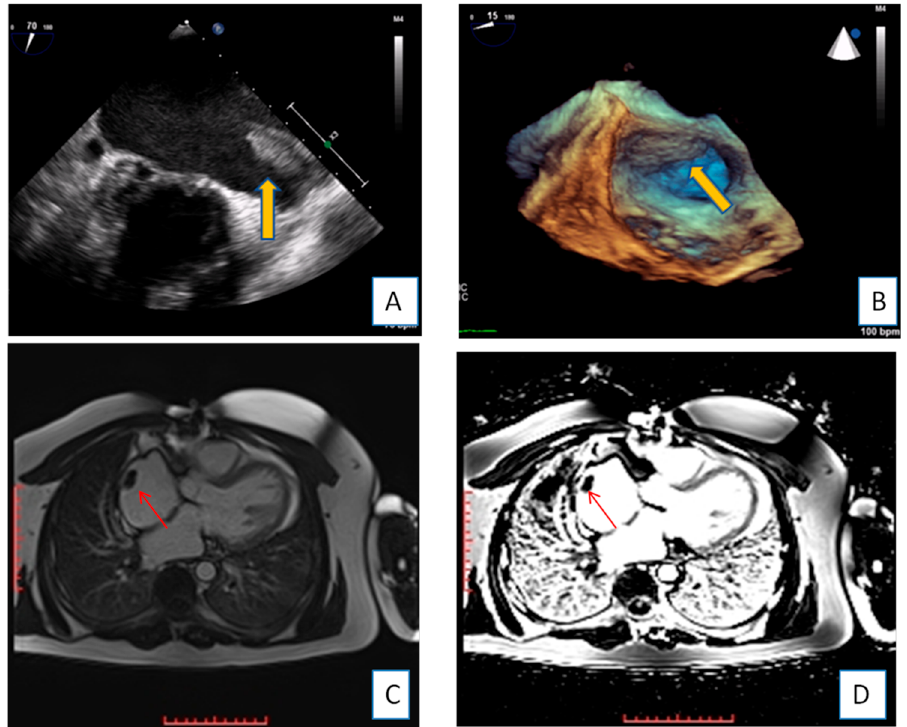
Figure 1. Transesophageal echocardiography depicting the left atrial appendage using 2D and 3D approach (( A,B ), respectively). A huge thrombus (arrows) is demonstrated in the upper part of the “coumadin ridge” is an elderly woman with severe mitral stenosis. Clot in the RA (red arrows). Cine and EGE imaging (( C,D ) respectively).